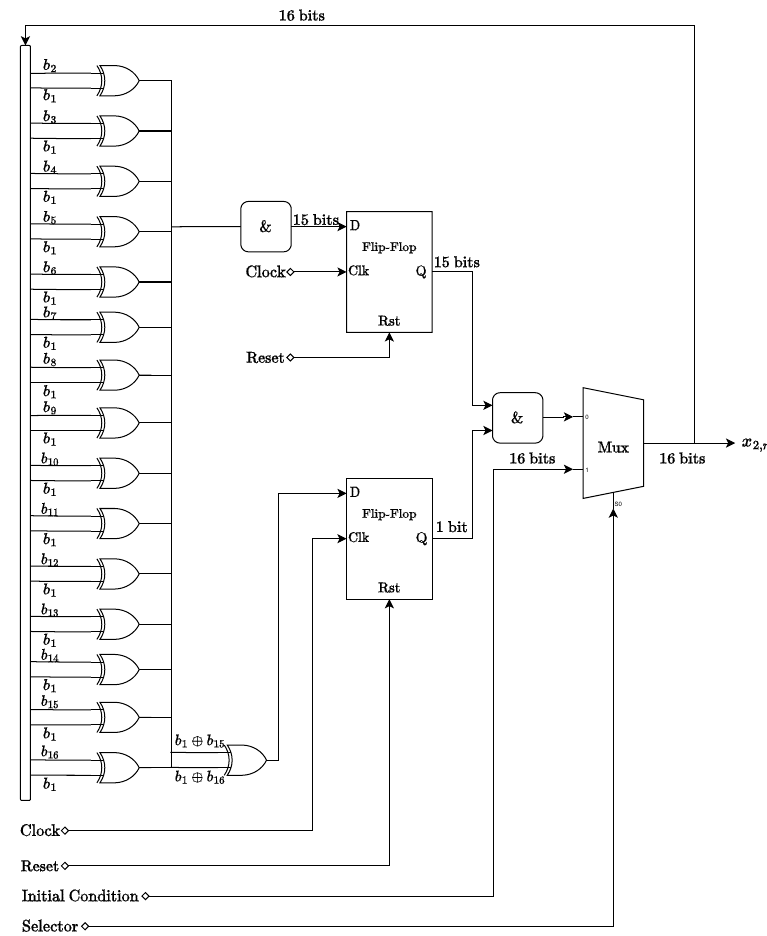
Figure 2. A digital representation of the tent